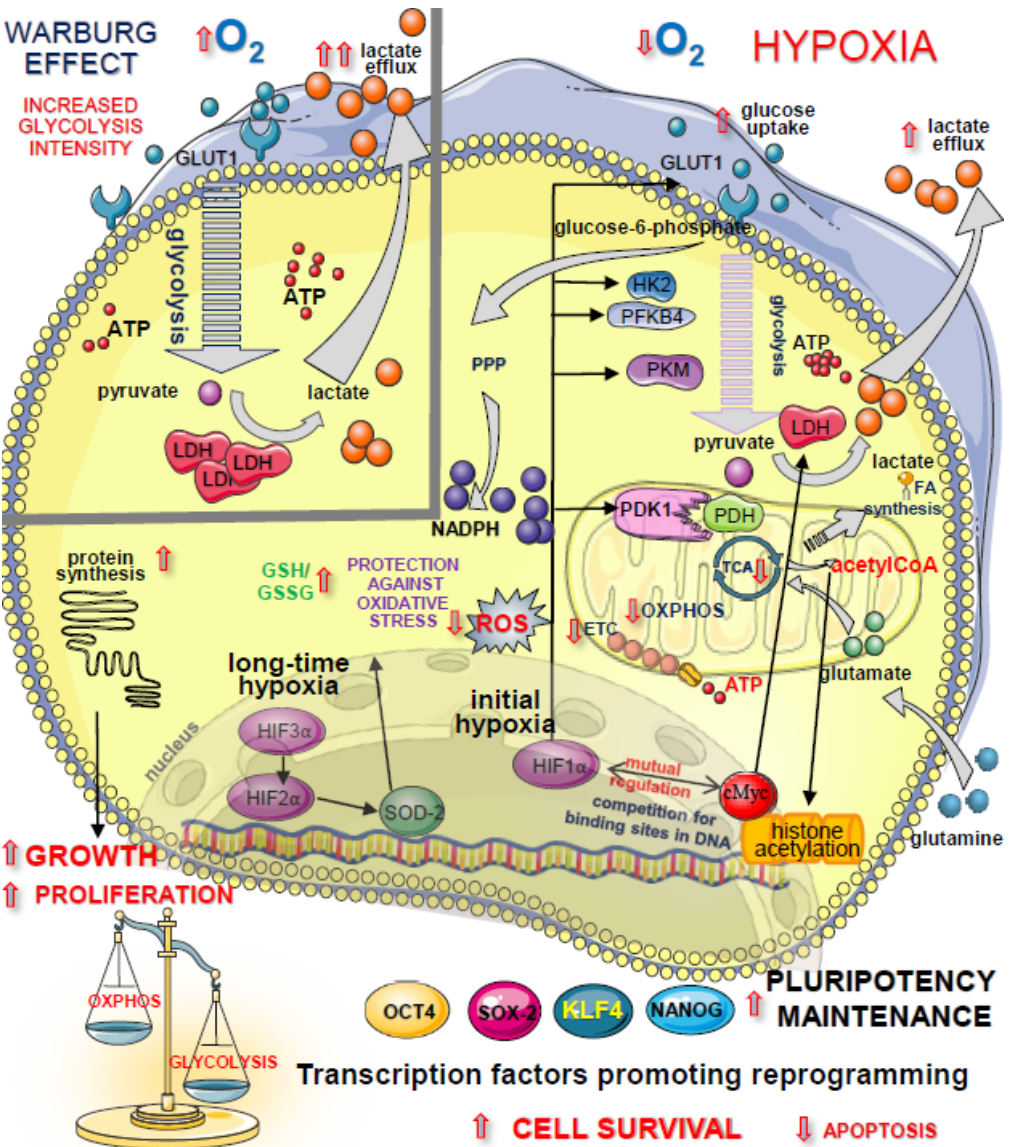
Figure 3. Outline of the cellular metabolism under hypoxic conditions. Both transcription factors, HIF1 α and HIF2 α , inhibit mitochondrial glucose consumption by restraining pyruvate transport to mitochondria, with less ROS as a by-product and abundant ATP synthesis from glycolytic pathways. HIF1 α governs the expression of transcripts for glucose transporter GLUT1 and glycolytic enzymes (HK2, PFK). High c-MYC expression increases the catabolism of glucose to lactate and glutamine flux into the TCA cycle as well as increases protection against oxidative stress via PPP (by production of reduced NADPH for glutathione regeneration). HIF3 α facilitates HIF2 α transcription and curbs HIF1 α expression. Upper part: the comparison of the intensity of glycolytic flux under hypoxia (low O 2 concentration; right panel) and during “Warburg effect” (O 2 concentration in the air; left panel). Abbreviations: ATP—adenosine